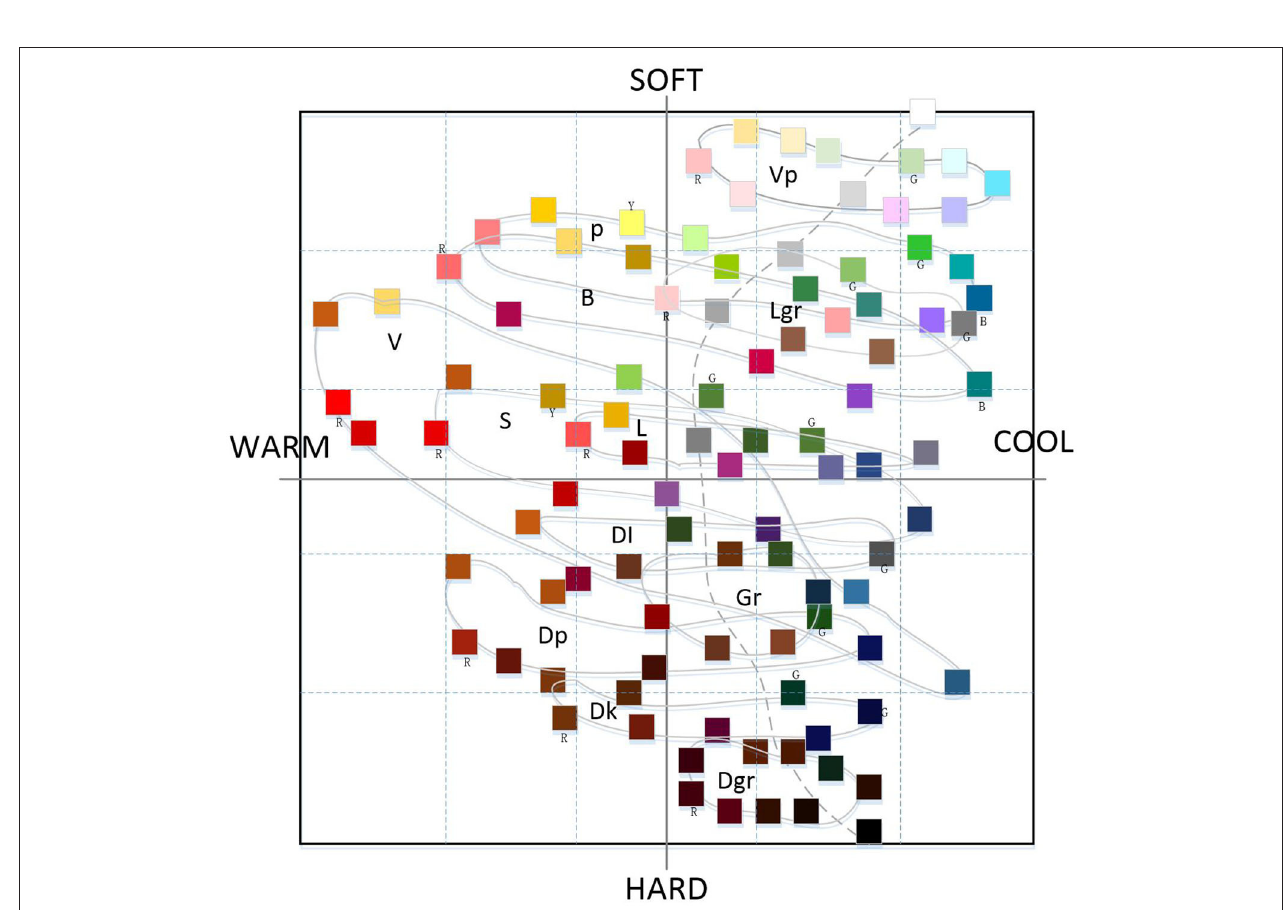
FIGURE 2 | Monochrome image